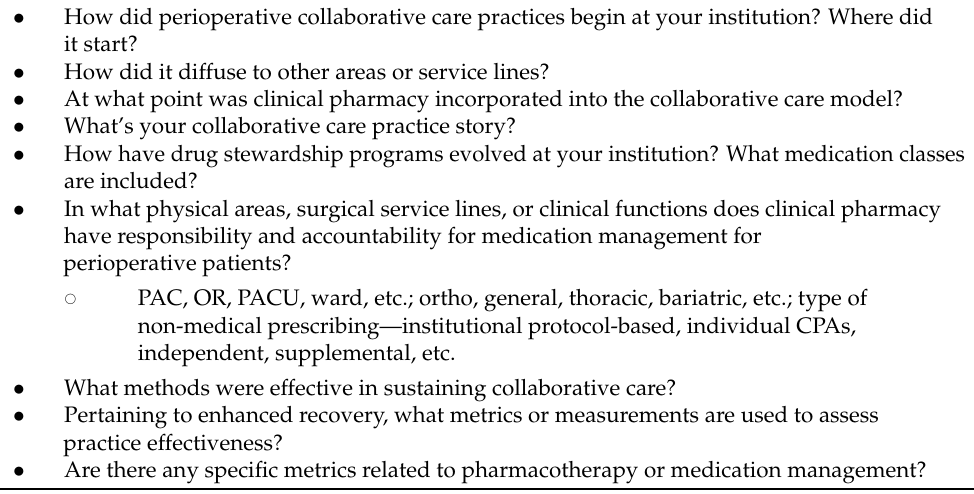
Table 1. Questions about Collaborative Care Practices Used for Perioperative Advanced Practice or Clinical Pharmacist Interviews (see Supplementary Materials File